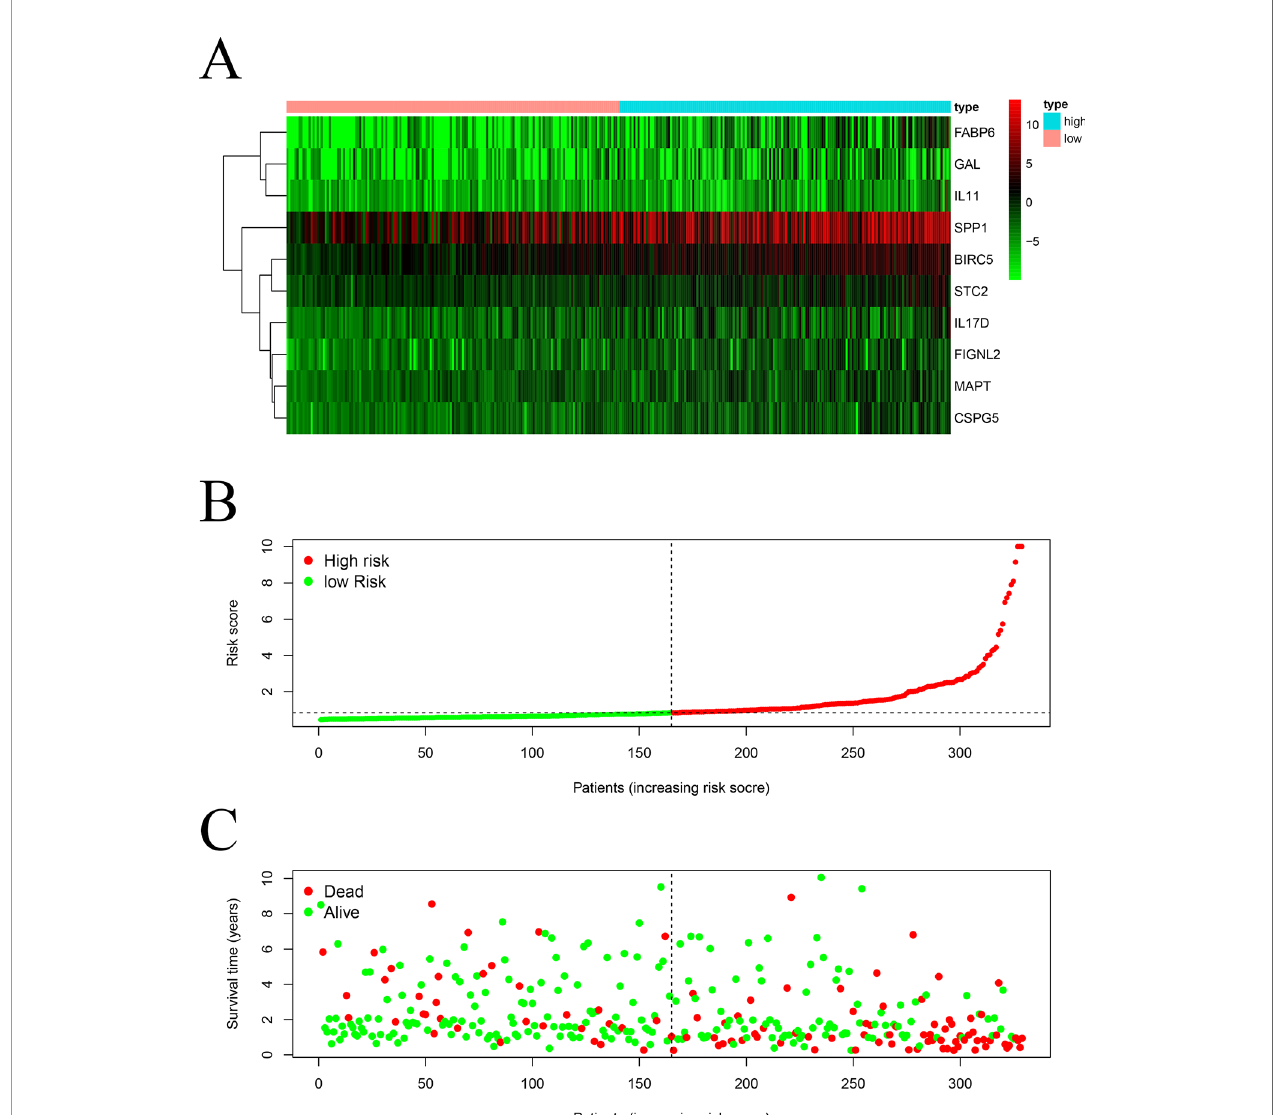
FIGURE 3 | Construction of a TCGA prognostic model using survival-associated IRGs: Heatmap (A) of survival-associated IRGs in the prognostic model. (B) Rank of risk score and distribution of groups. (C) Survival status of patients in different